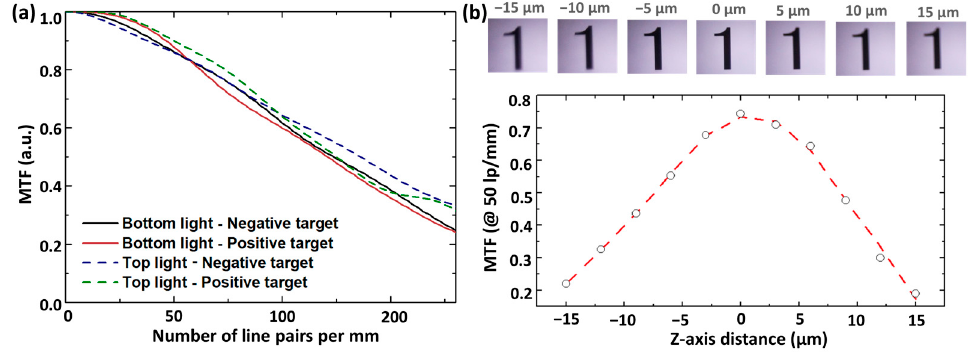
Figure 3. Imaging performances of MCM. ( a ) Measured MTF curves according to illumination directions and targets through the slanted-edge method. ( b ) Thru-focus MTF according to target distances. The MTF was determined at the spatial frequency of 50 line pairs per mm.